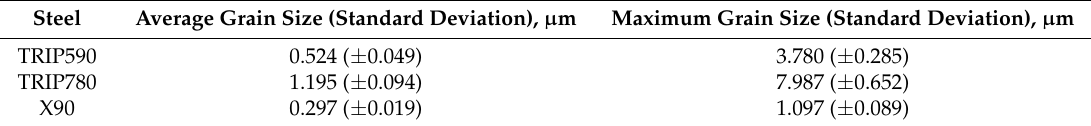
Table 5. The statistical results of average grain size and maximum grain size.